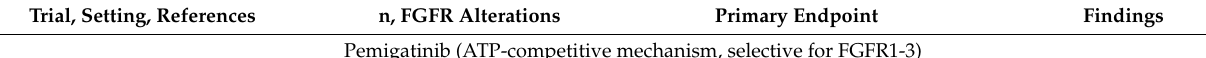
Table 1. Notable published clinical trials of FGFR inhibitors in advanced